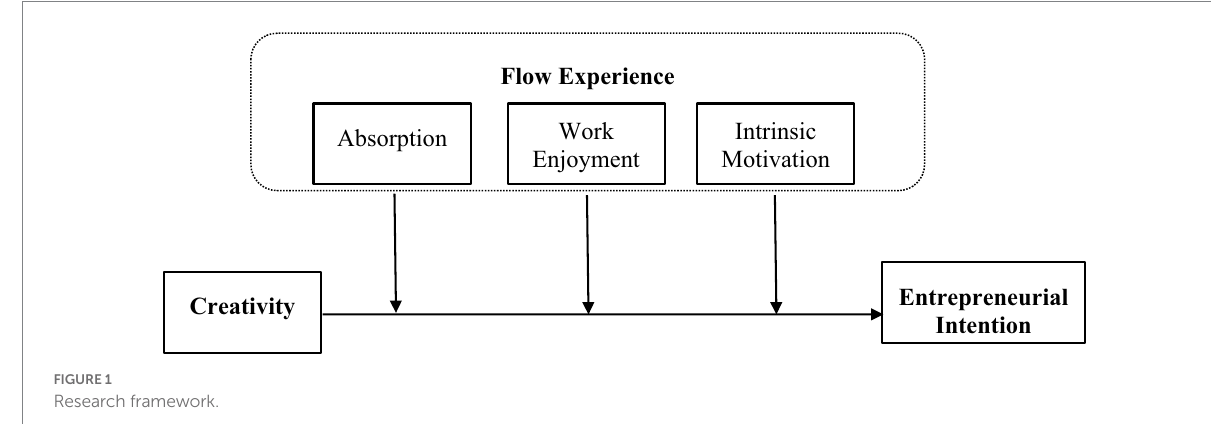
FIGURE 1 Research framework.